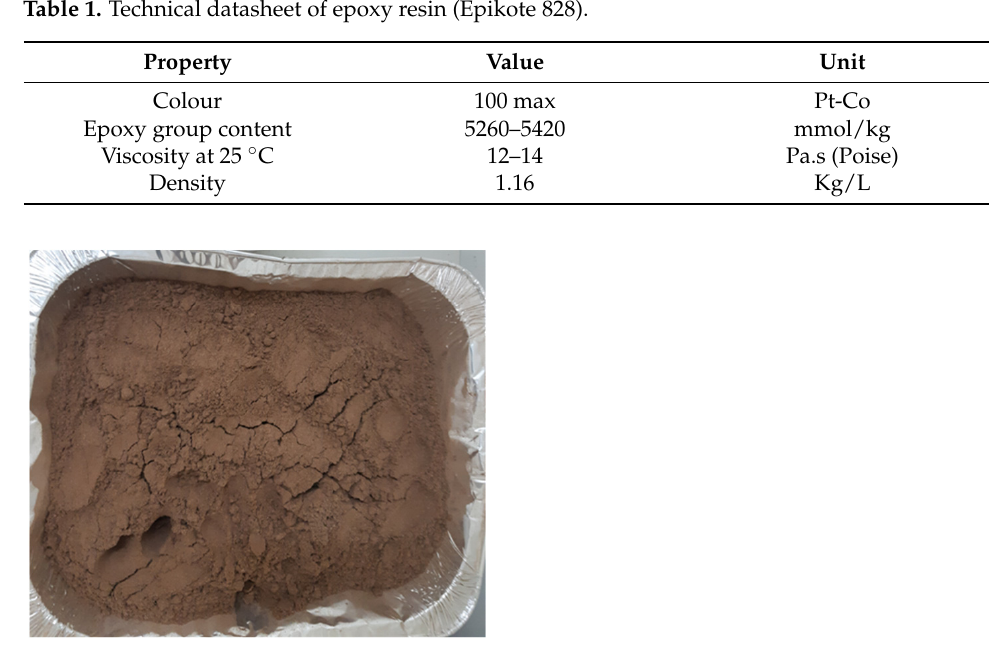
Figure 1. Palm kernel cake filler with size of 100 mesh.